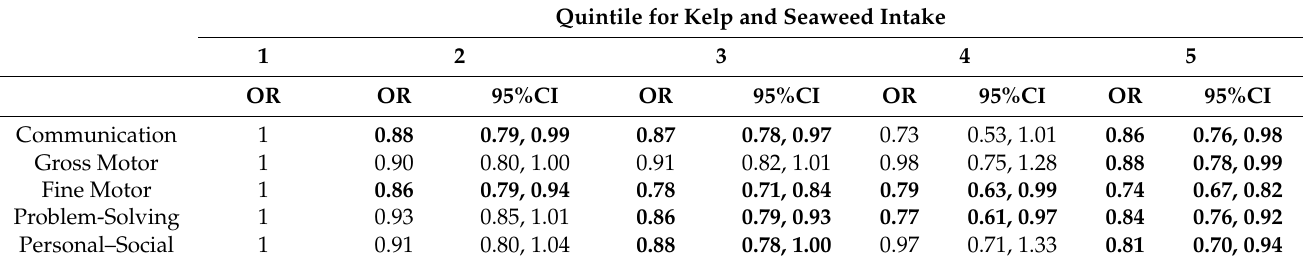
Table 5. Adjusted ORs and 95% CIs for child neurodevelopmental delay at 3 years of age based on maternal kelp and seaweed intake in multiple binomial logistic regression